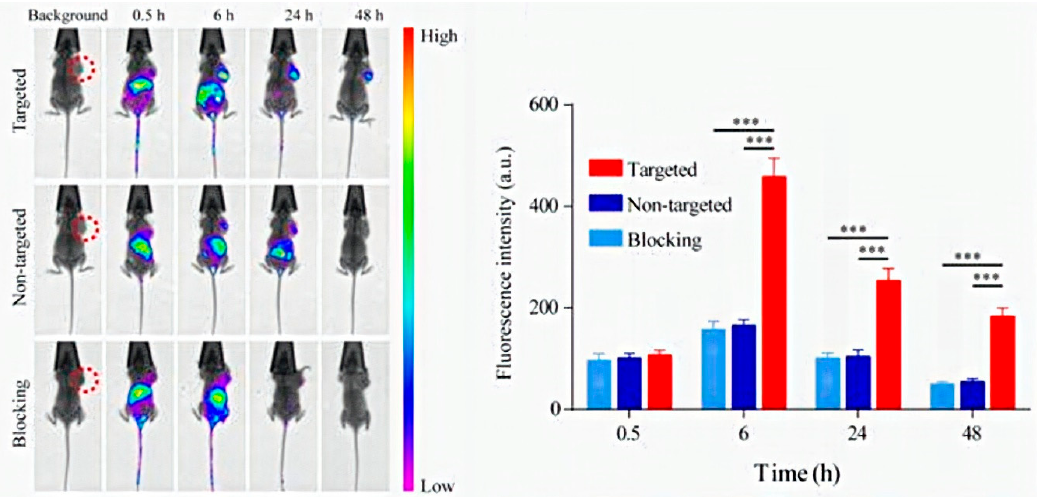
Figure 1. In vivo imaging of tumor-bearing mice after the injection of mesoporous silica nanoparticles (MSN) decorated with YQ26 aptamer. Left image shows the accumulation of nanocarriers in the tumor located in the flank of the mice. The graph located in the right quantified the accumulation of nanocarrier by fluorescence. ∗∗∗ p < 0.001. Reproduced from [41], Ivyspring International Publisher, 2017.